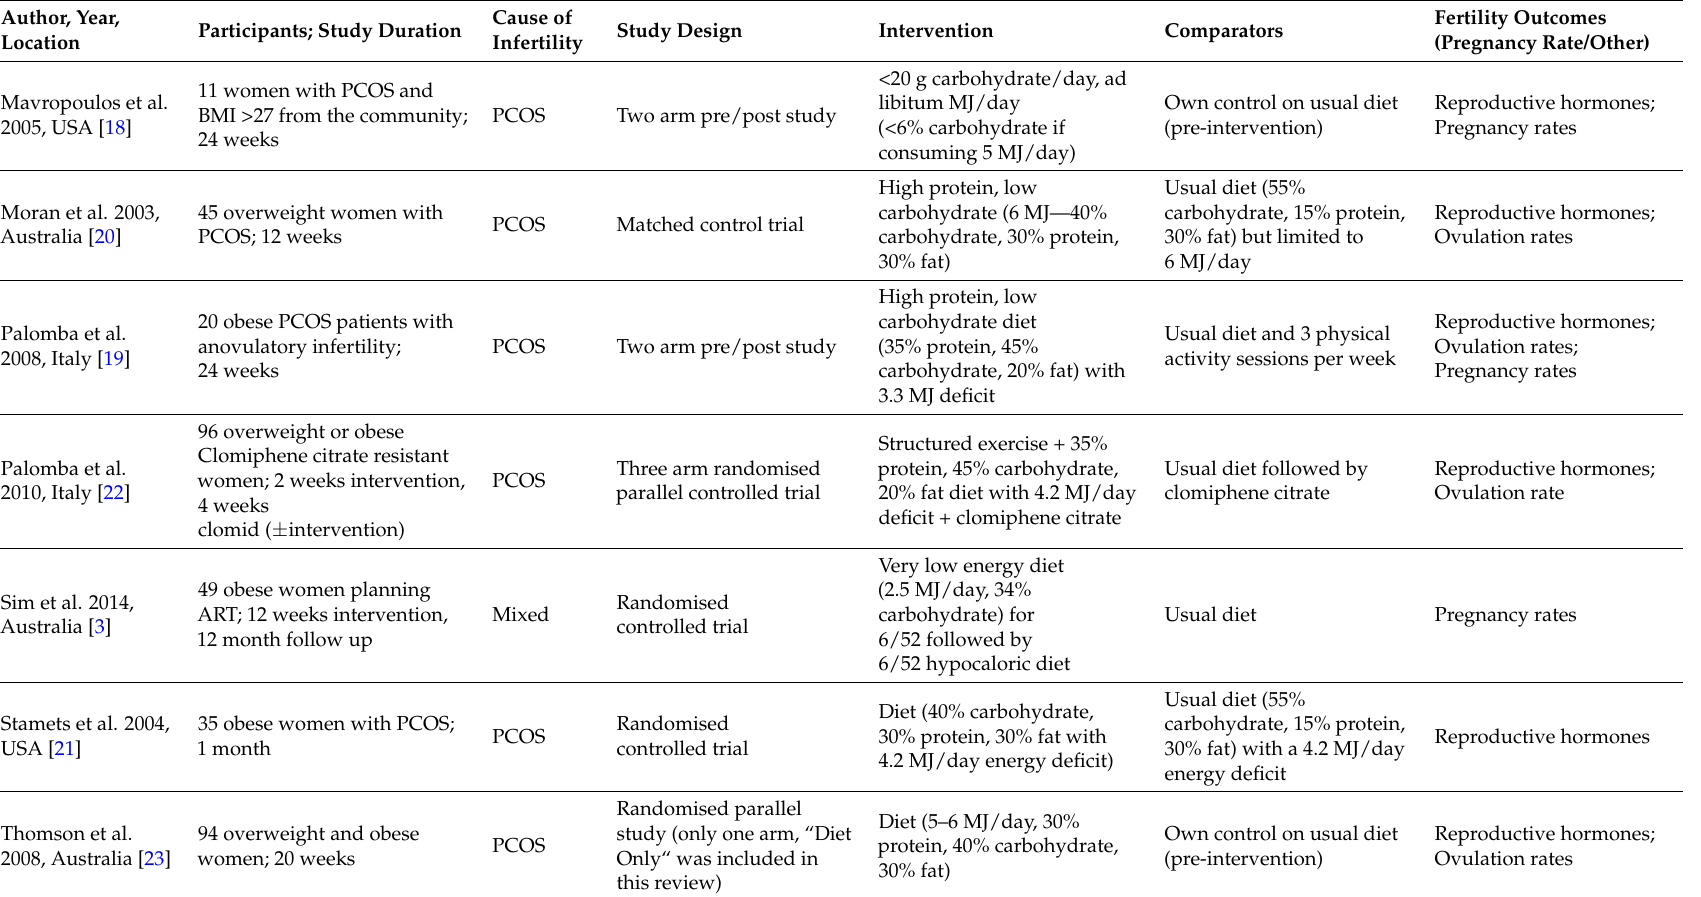
Table 1. Studies of low carbohydrate diets in overweight and obese women measuring fertility hormones and other reproductive